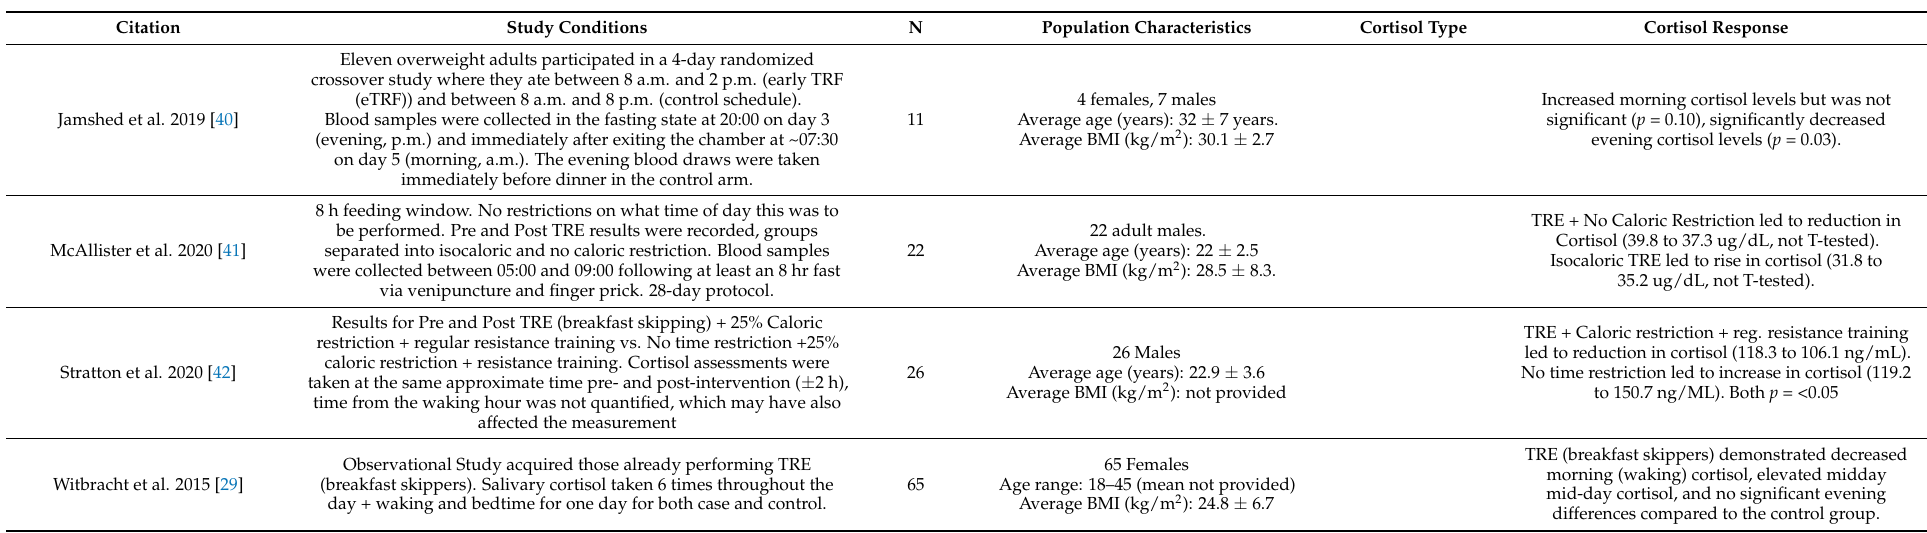
Table 2. Study Characteristics of Included Papers on Day-time Time Restricted